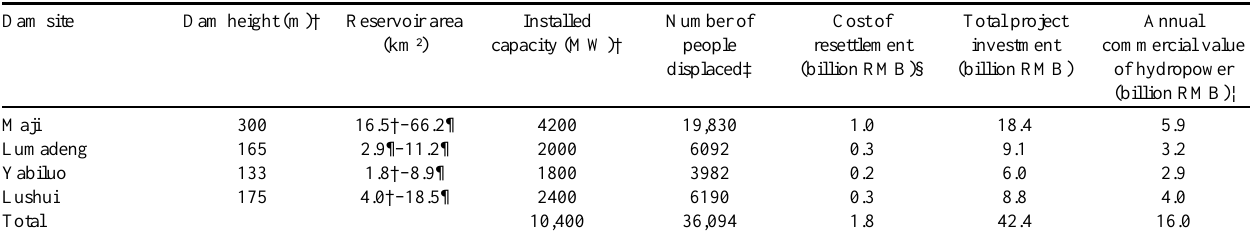
Table 1. Characteristics of four proposed hydroelectric dams on the Nu River, China. Dam